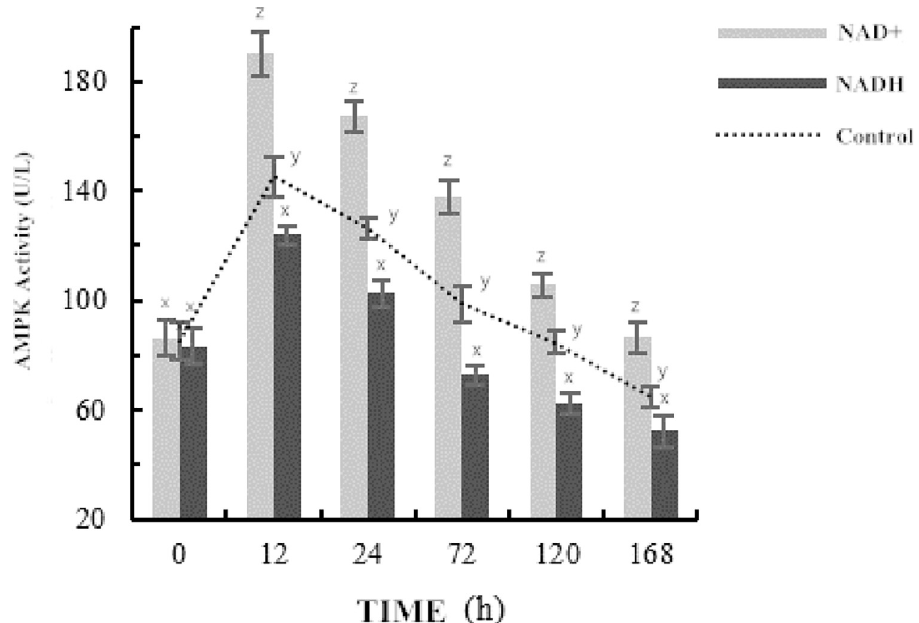
Fig 1. Changes of AMPK activity during post-mortem